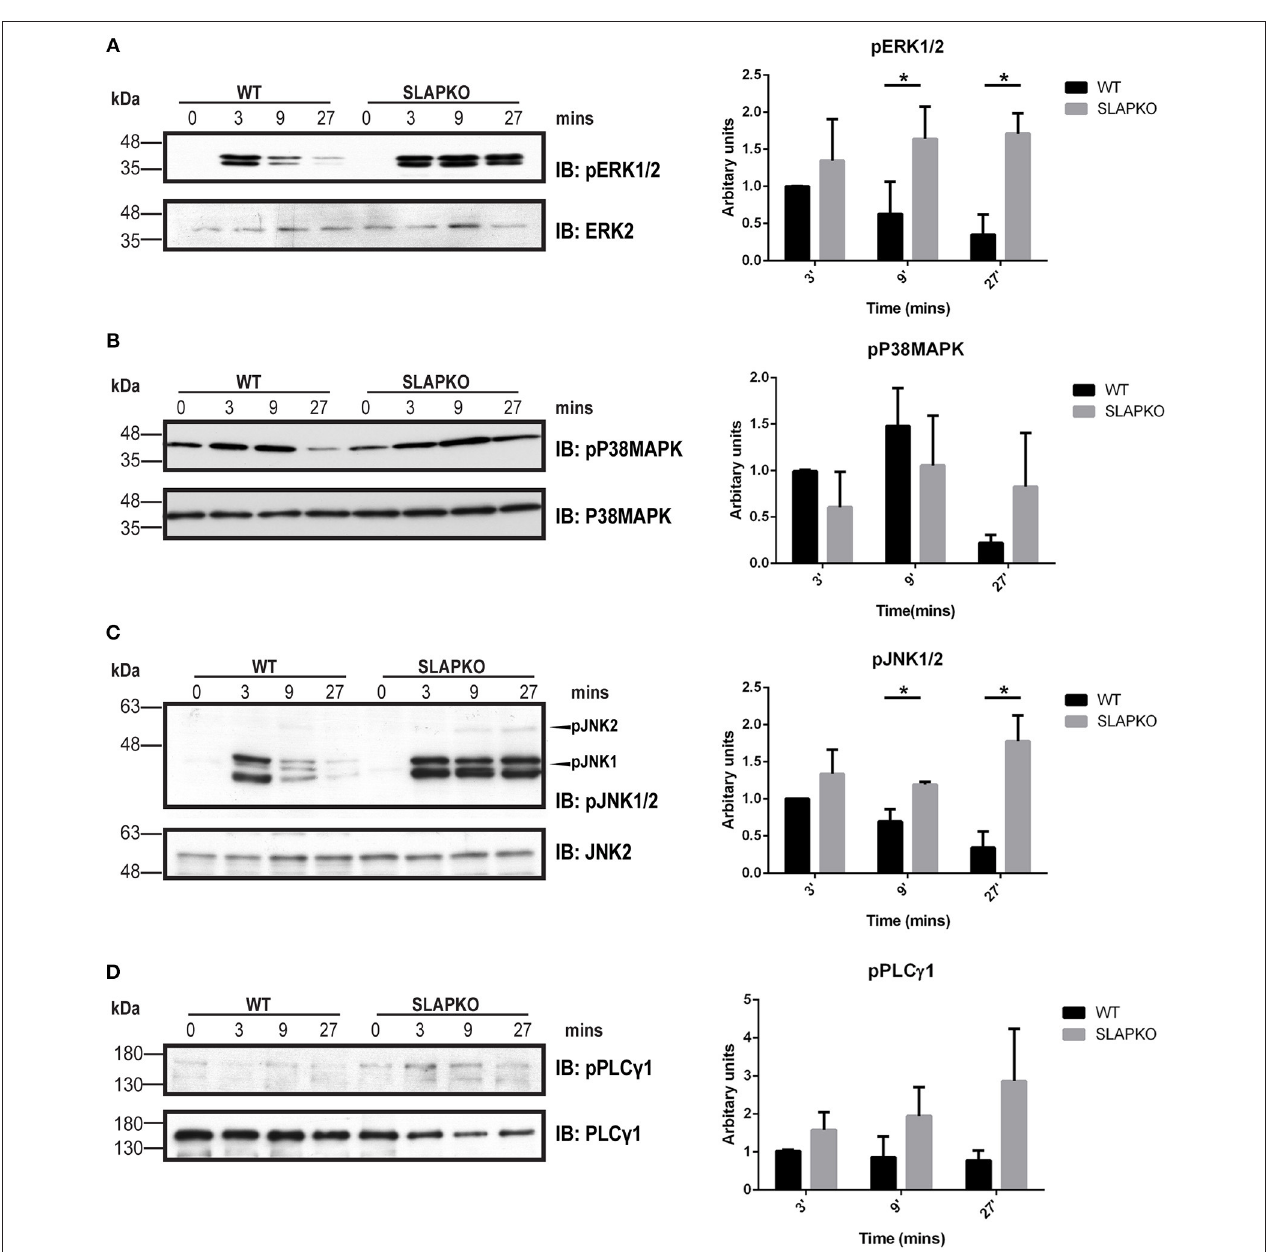
FIGURE 6 | SLAP perturbs the MAPK signaling downstream of Fc ε RI. WT and SLAP KO BMMCs were starved and sensitized with anti-DNP IgE for 18h and then stimulated with DNP-HSA (50ng/ml) for indicated time-points. (A) Lysates were prepared and subjected to immunoblot (IB) with anti-phospho-ERK1/2 (pERK1/2), and ERK2 Abs, (B) anti-p-P38MAPK, and P38MAPK Abs (C) anti-pJNK1/2 and JNK2 (D) anti-pPLC γ 1, and PLC γ 1 Abs. Representative immunoblots of three separate experiments are shown ( n = 3). Positions of relative mass markers in kilodaltons (kDa) are shown on the left. Bar graph represents the quantitation of relative levels of indicated phospho-proteins at given time points by densitometry quantification. Data (mean ± SD) in bar graph represents the pooled data from three independent experiments ( n = 3) and compared with Student’s t -test; * P < 0.05.